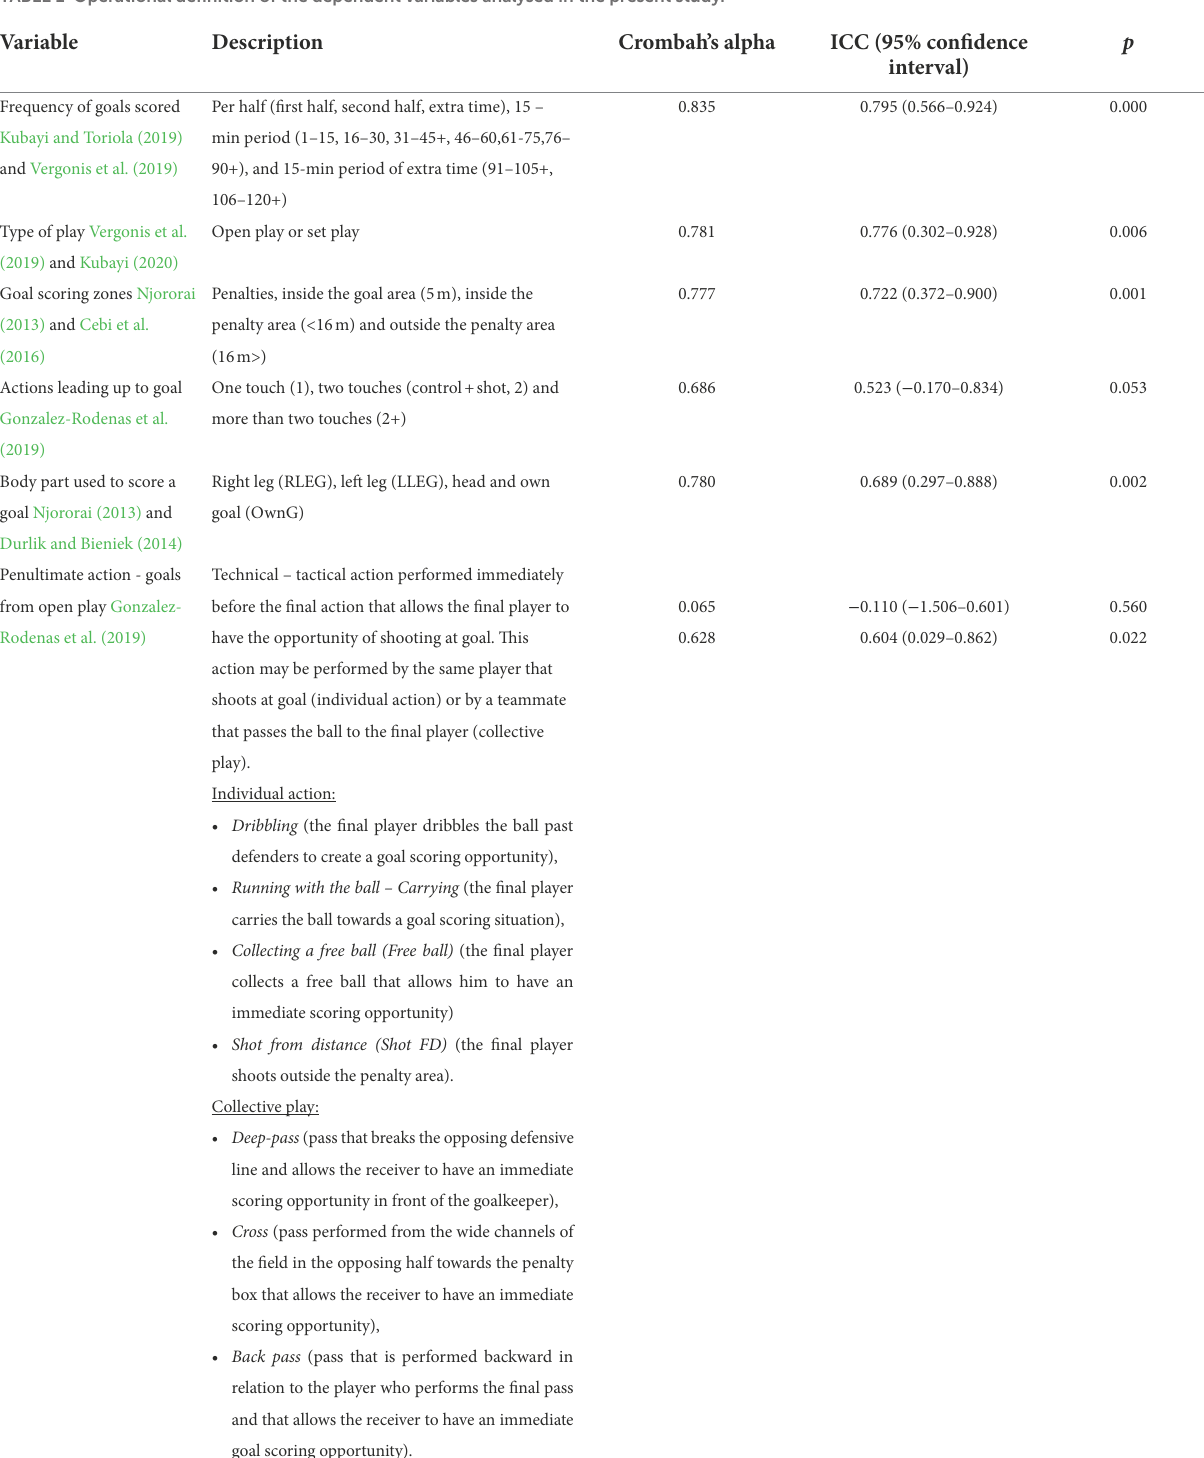
TABLE 1 Operational definition of the dependent variables analysed in the present study.